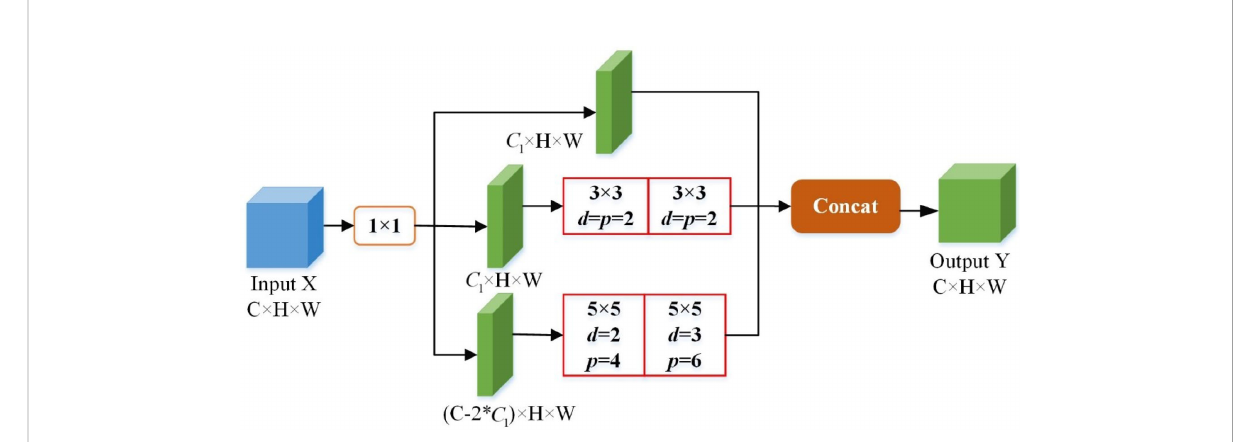
FIGURE 3 Schematic showing the convolution kernels adopted by the JDC module Structure of JDC module, where C is the number of channels, H is the height of the feature map, W is the width of the feature map, d refers to dilation rate, and p refers to